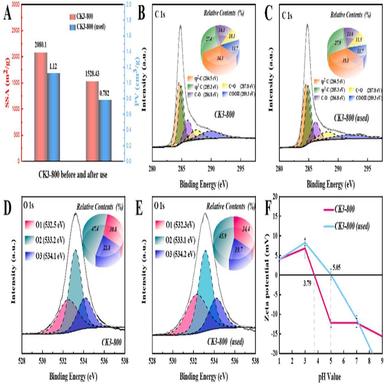
Textural properties (A), XPS spectra of C1s (B–C), XPS spectra of O1s (D–E), and pHzpc (F) of CK3–800 and used CK3–800.